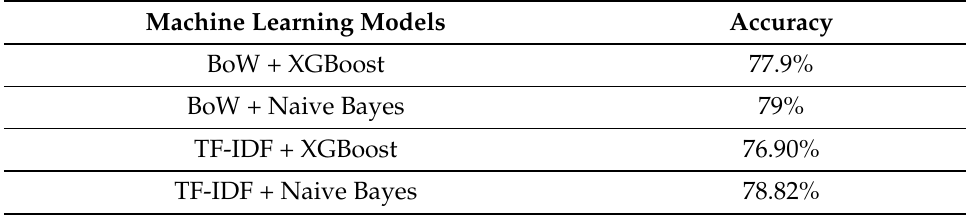
Table 16. Comparison among machine learning models.